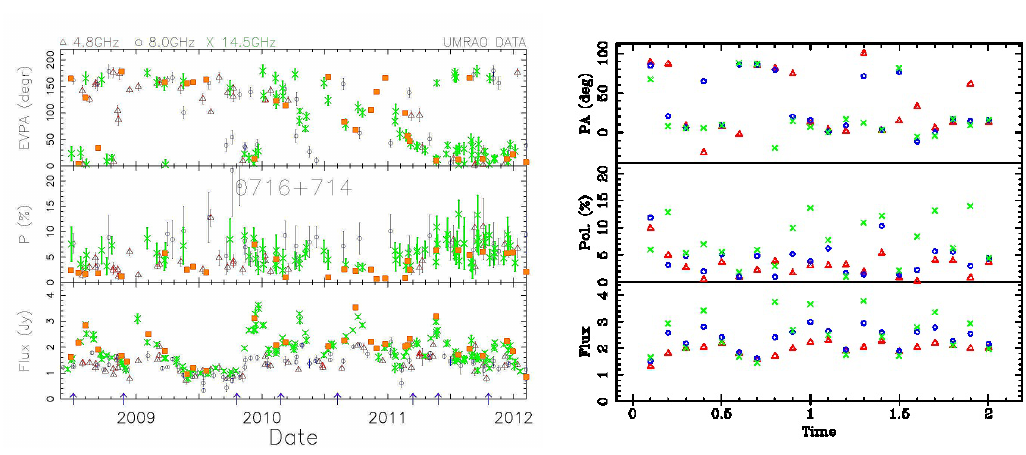
Figure 2. ( Left ): Daily-averaged centimeter-band data for 0716+714 during the modeled time window. UMRAO data are color and symbol coded as in Figure 1. MOJAVE data are shown with gold squares; ( Right ): The simulated light curves based on the adopted jet and shock parameters.